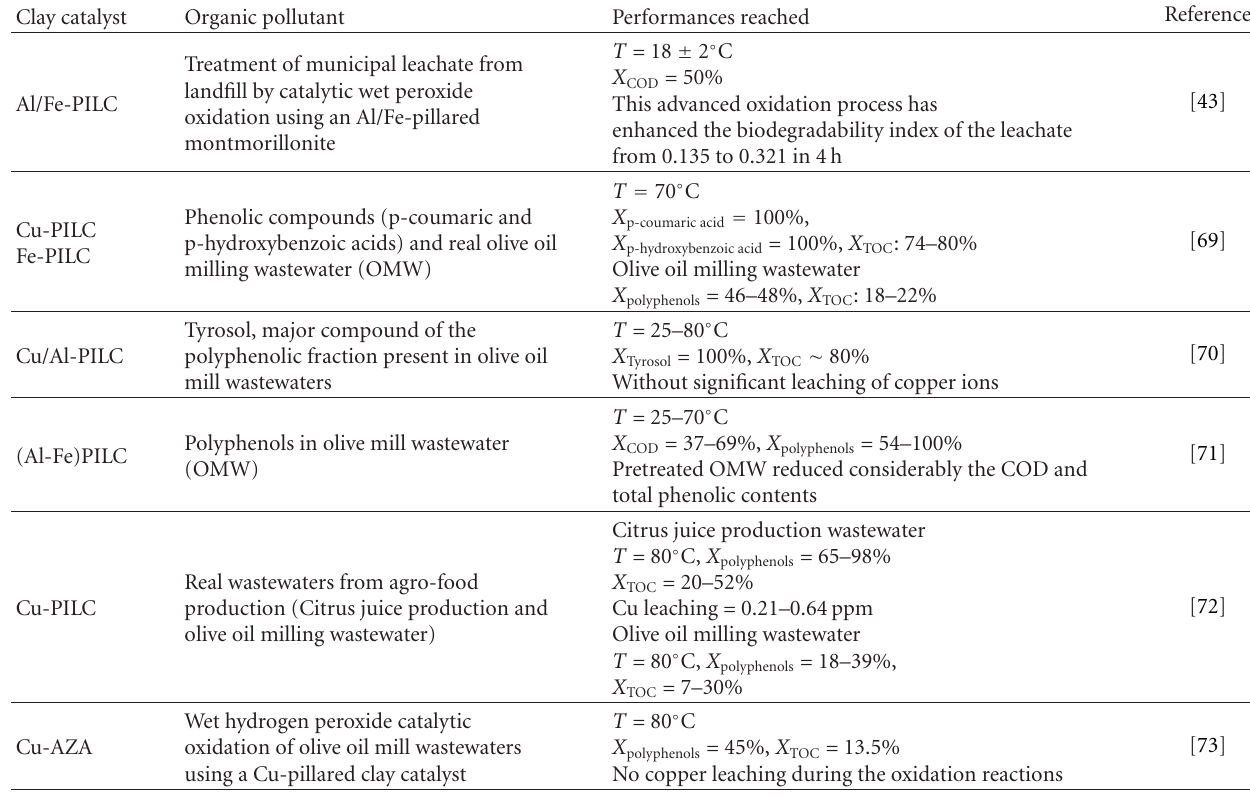
Table 3: Some examples of WPHCO of water pollutants (model molecules) or real e ffl uents, using a Fenton reaction catalyzed by pillared